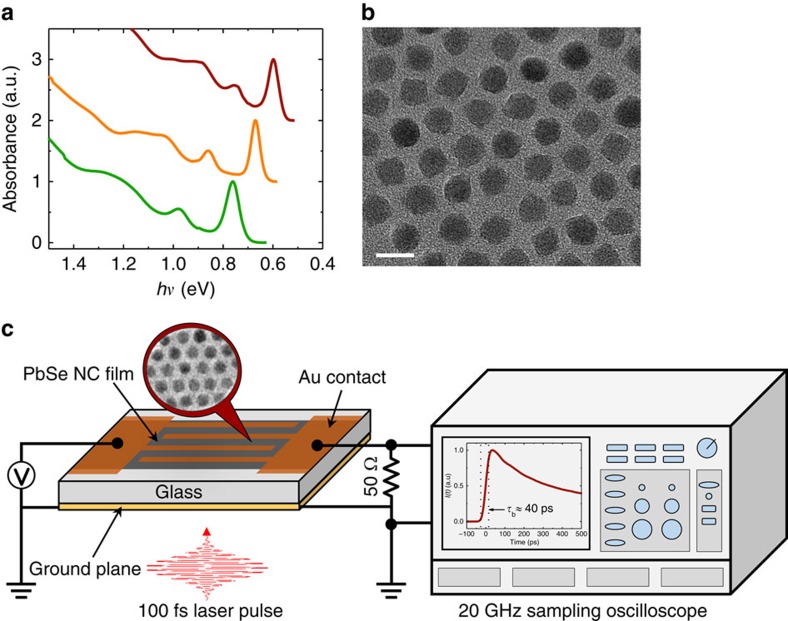
Schematic of TPC measurements.(a) Absorption spectra of QDs of three different mean radii of 2.8 nm (bottom), 3.0 nm (middle) and 3.5 nm (top). (b) An example of a transmission electron microscopy image of PbSe QDs with a mean radius of 3.5 nm, scale bar is 10 nm. (c). A photoconductive switch comprises a thin film of PbSe QDs deposited on a glass substrate with top interdigitated Au contacts. Photocurrent is excited by short ∼100 fs laser pulses and monitored with a 20 GHz sampling oscilloscope. An example of a TPC trace on the oscilloscope's screen shows a ca. 40 ps buildup (τb) corresponding to the time for the signal to increase from 10 to 90% of the peak amplitude; this constitutes the overall temporal resolution of the system.